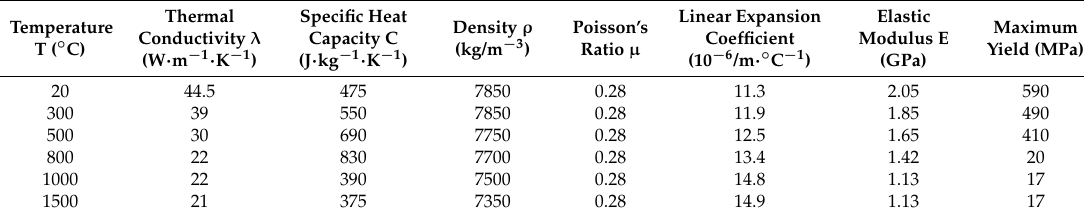
Table 3. Material parameters of 12CrNi2 steel.